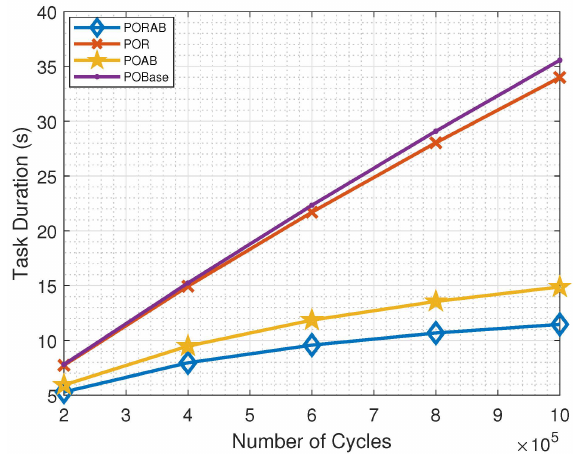
Figure 8. Variation of task computation time with the number of cycles required to process a